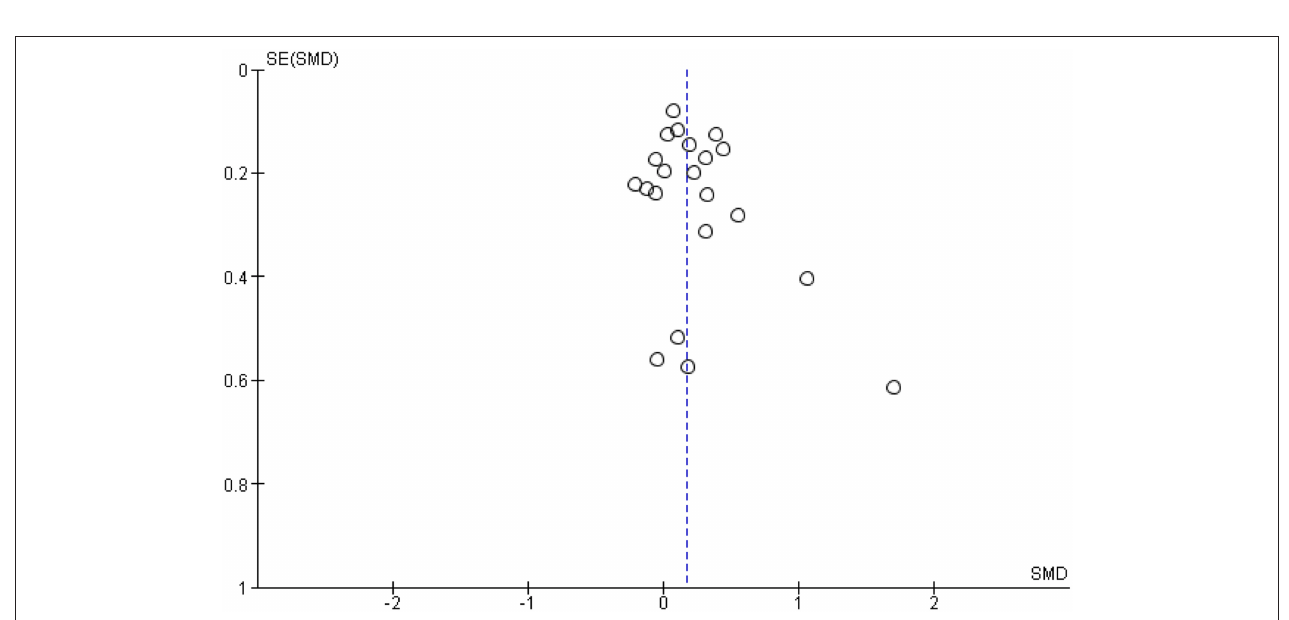
FIGURE 3 | Funnel plot of Case management vs. TAU comparison: Overall CM effect across outcome categories.